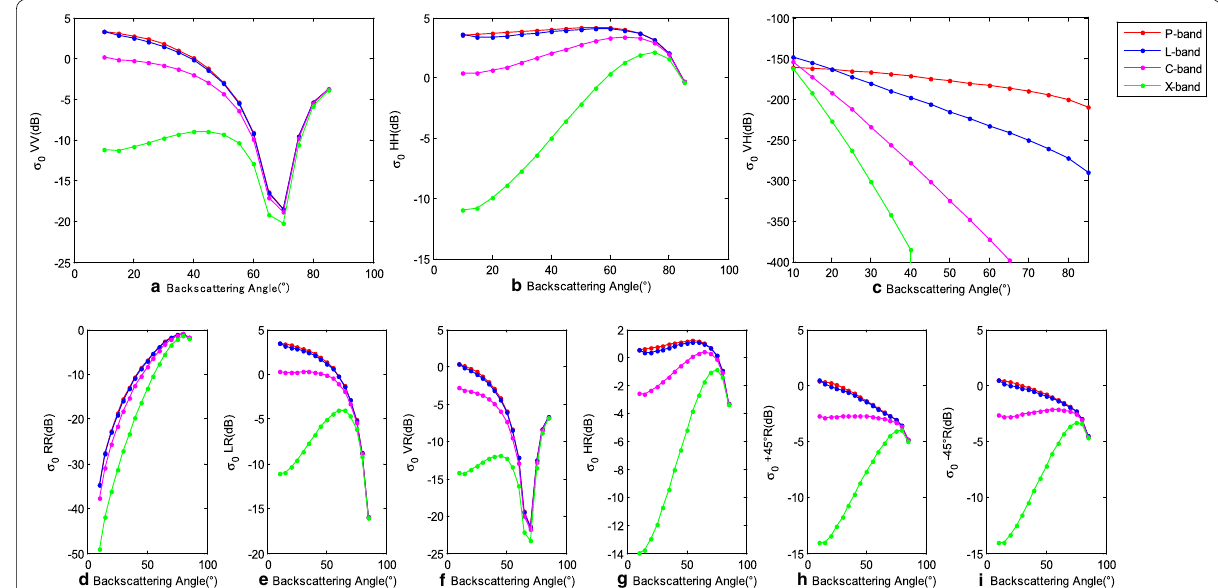
Fig. 5 Various polarizations random rough surface scattering cross section versus scattering angle for P-, L-, C- and X-band at backscattering